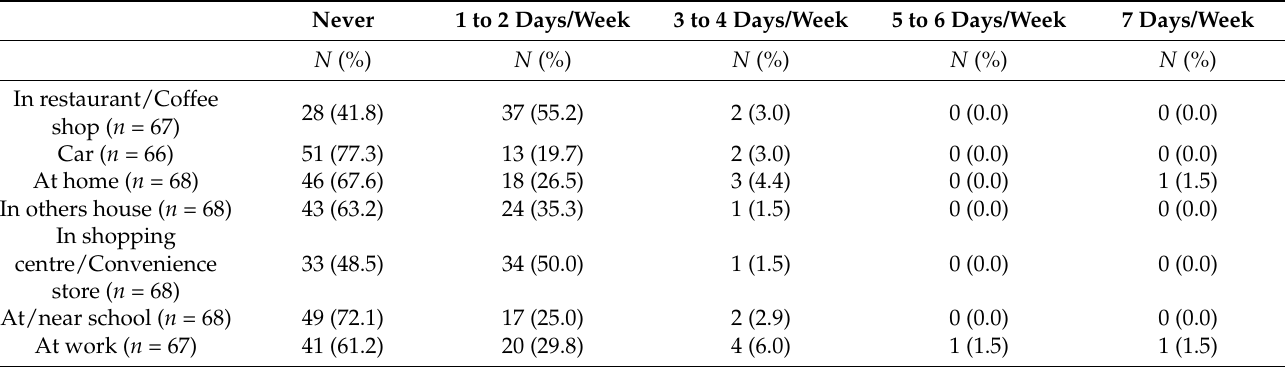
Table 2. Perceived frequency of SHS in multiple sites among pregnant